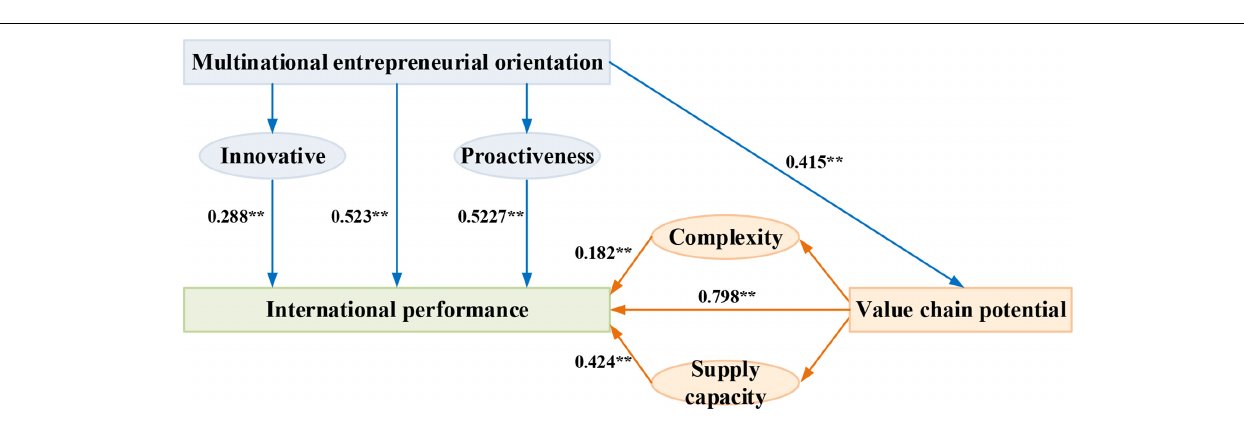
FIGURE 8 | Impact path of the multinational entrepreneurial orientation, value-chain potential, and international performance. ** represents P <